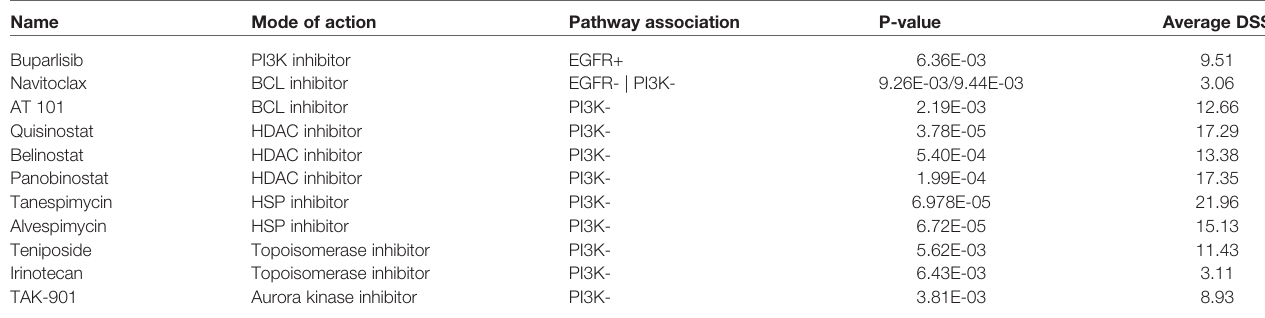
The pathway association denotes the positive (+) or negative (-) association between the pathway activation and the drug ef fi cacy. DSS, drug sensitivity score.